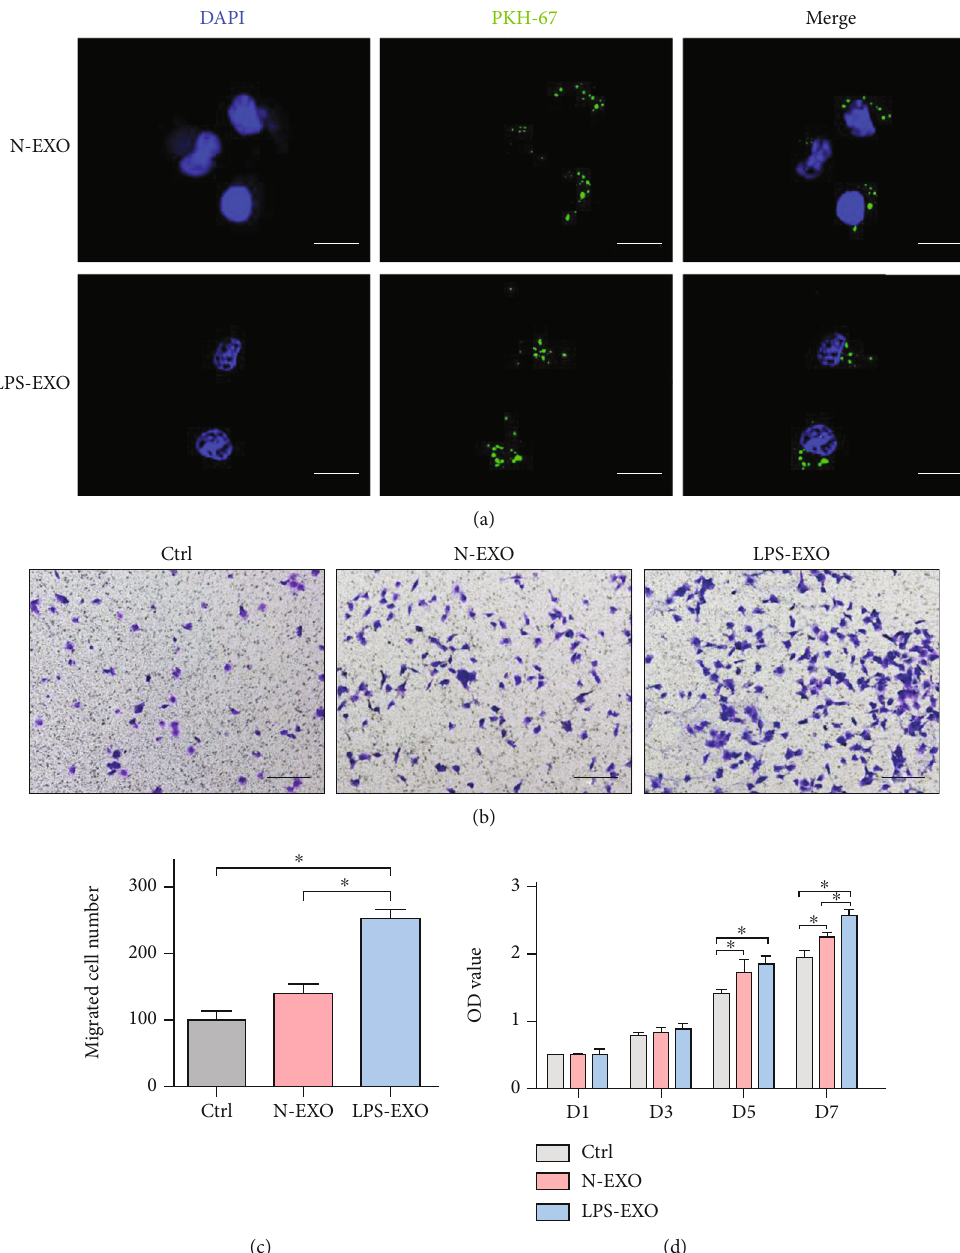
Figure 4: The proliferation and migration of HUVECs were promoted by the uptake of LPS-EXO. (a) Uptake of PKH-67-labeled exosomes by HUVECs (scale bar, 25 μ m). (b) Representative images of the Transwell migration assay. LPS-EXO promotes the migration of HUVECs (scale bar, 200 μ m). (c) Quanti fi cation analysis of the migrated HUVEC number in 24 hours ( n = 3 ). (d) The proliferation of HUVECs. LPS- EXO promotes proliferation of HUVECs in 5 and 7 days ( n = 3 ). Data represent means ± SD . ∗ P < 0 : 05